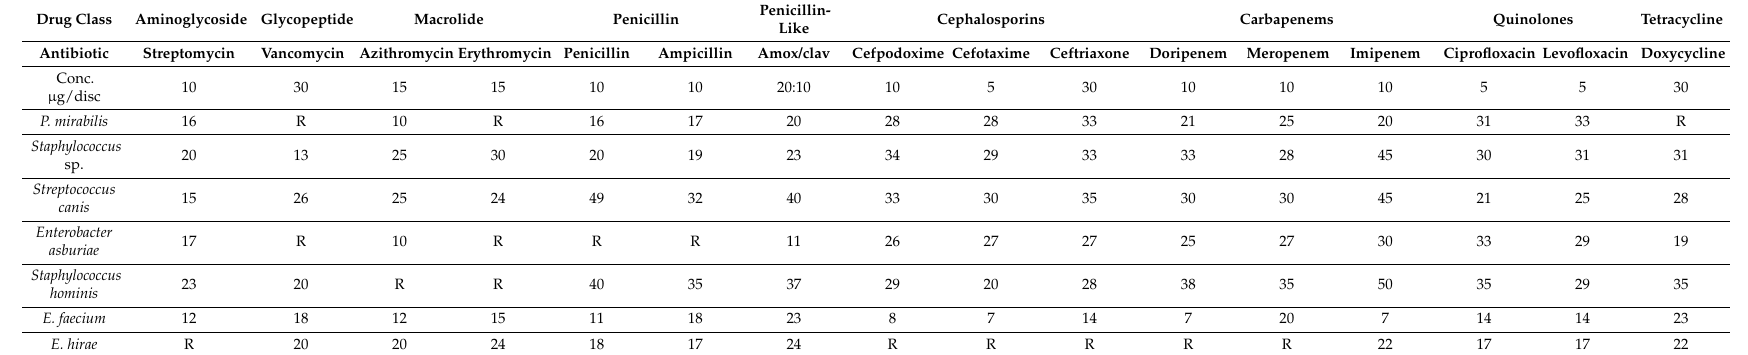
R donates complete resistance to antibiotic, evident by absence of any zone of